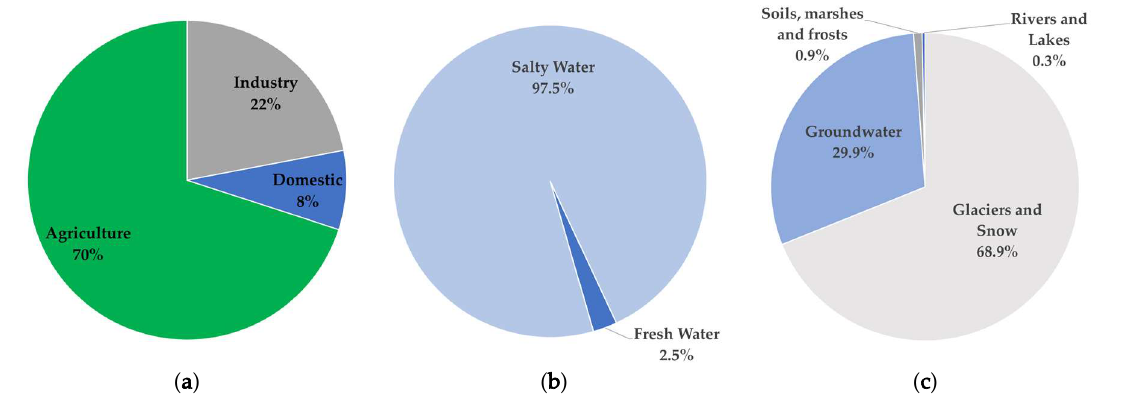
Figure 1. World water consumption and water distribution [3]. ( a ) Water consumption, ( b ) global total water, ( c ) 2.5% global total freshwater.